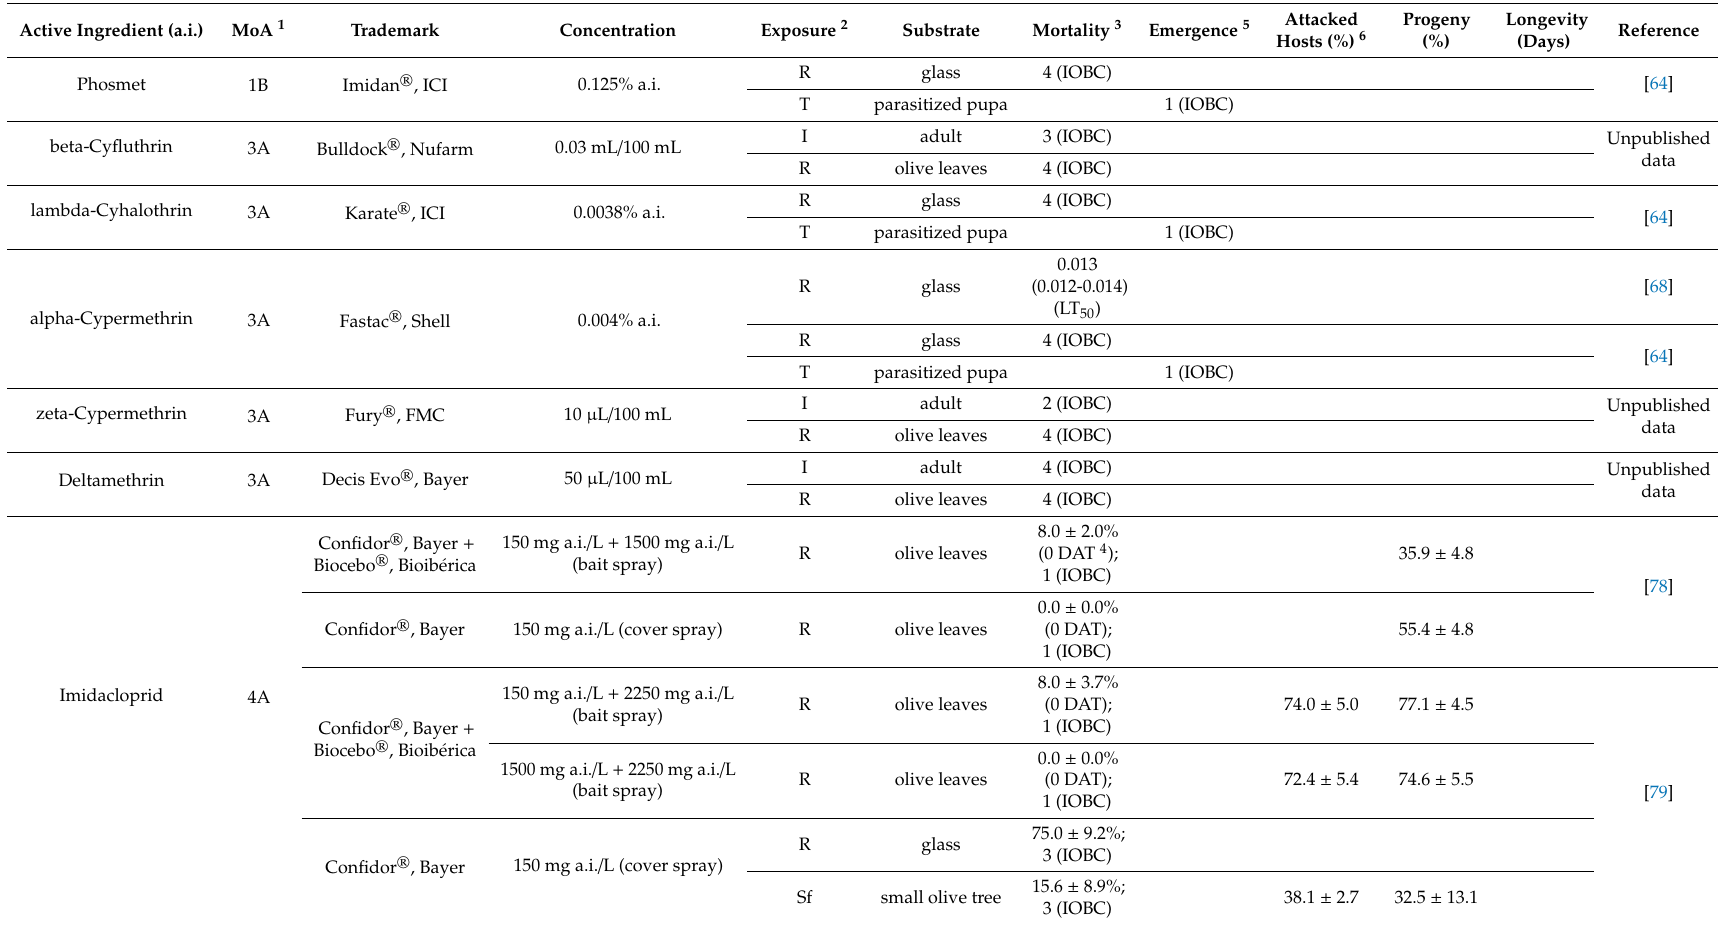
Table 1. Toxicity of insecticides, currently registered in the European Union, tested on Psyttalia concolor adults. Active Ingredient